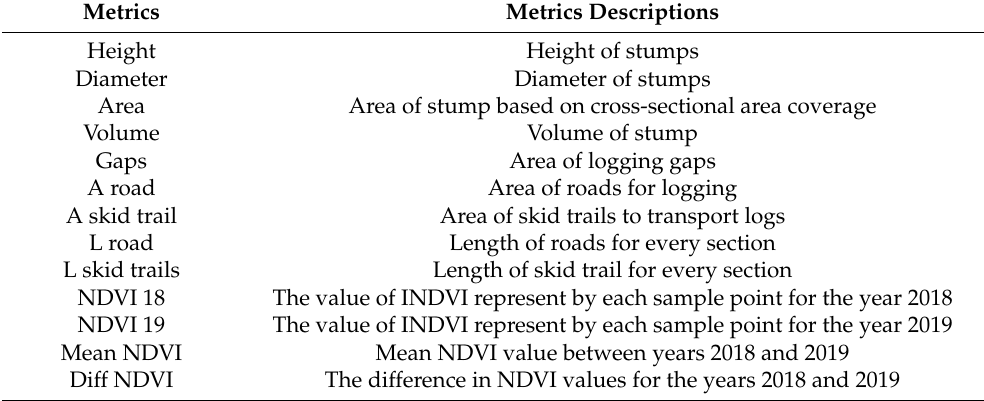
Table 3. Metrics derived from the UAV and satellite as independent